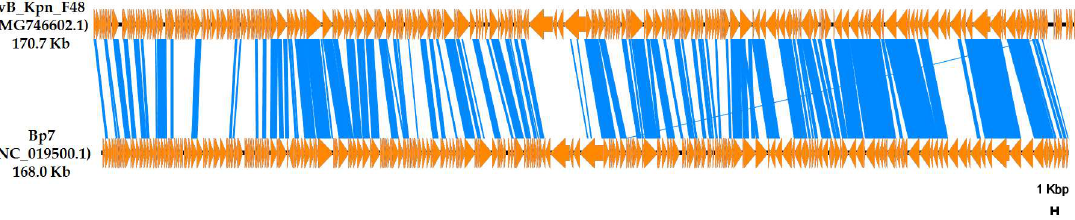
Figure 6. Comparative analysis between vB_Kpn_F48 and the Bp7 phage. Genetic map was constructed using EasyFig. ORFs are represented by orange arrows. Genome fragments having an identity ≥ 64% are connected by blue areas.